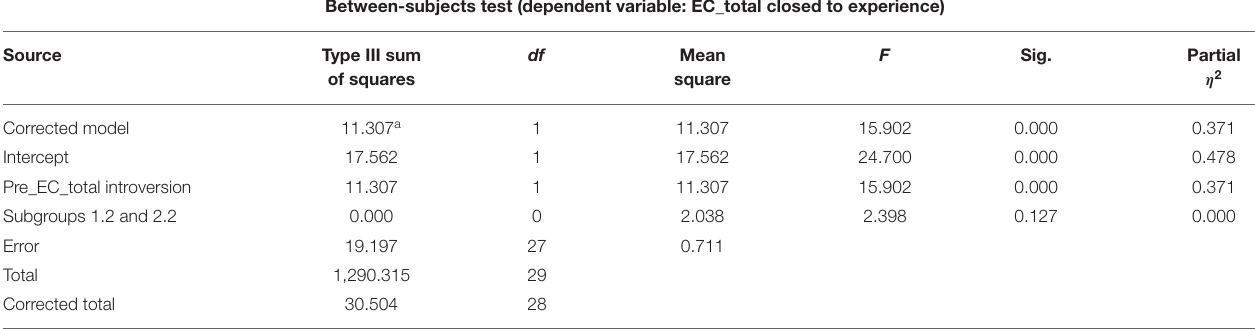
Between-subjects test (dependent variable: EC_total closed to experience)